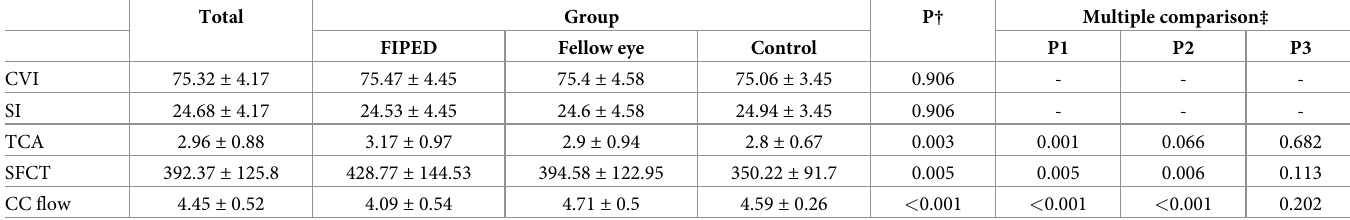
Table 3. Choroidal structure evaluation in three different groups.